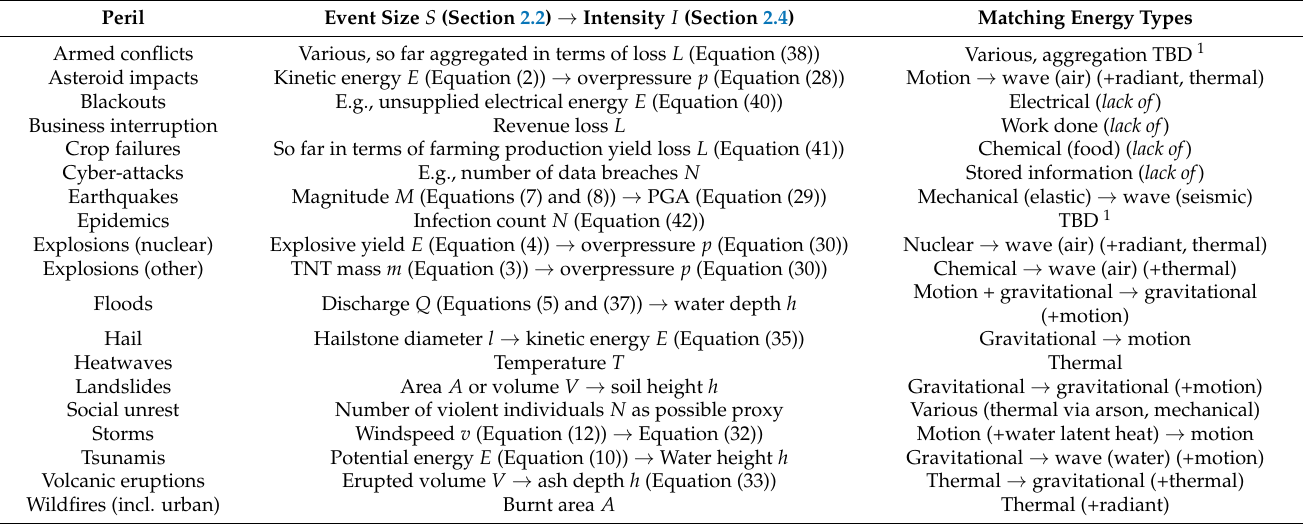
Table 1. Energy types per peril (indicative only,